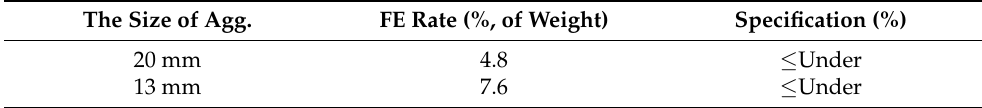
Table 3. Flat and elongation of the used aggregates.